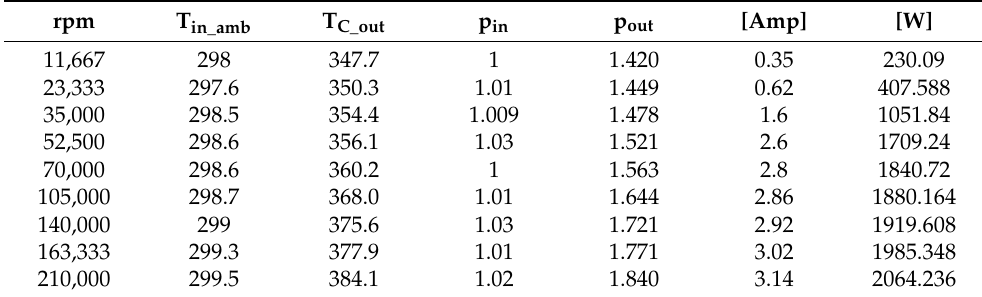
Figure 19. Assembling the device compressor-electric motor and test bench. ( a ) the shaft and its support and bearings; ( b ) the components device: 1. compressor wheel 2. electric motor 3. lubricating system housing 4. volute; ( c ) the assembled device with the instruments: 1. support for outlet pressure gauge and probe 2. amperometric clamp 3. thermocouples 4. multimeter connections 5. transfer device to PC 6. lubricating system. Table 10. Test Campaign Results: Temperature [K], Pressure [bar], Current [Amp], Power [W].